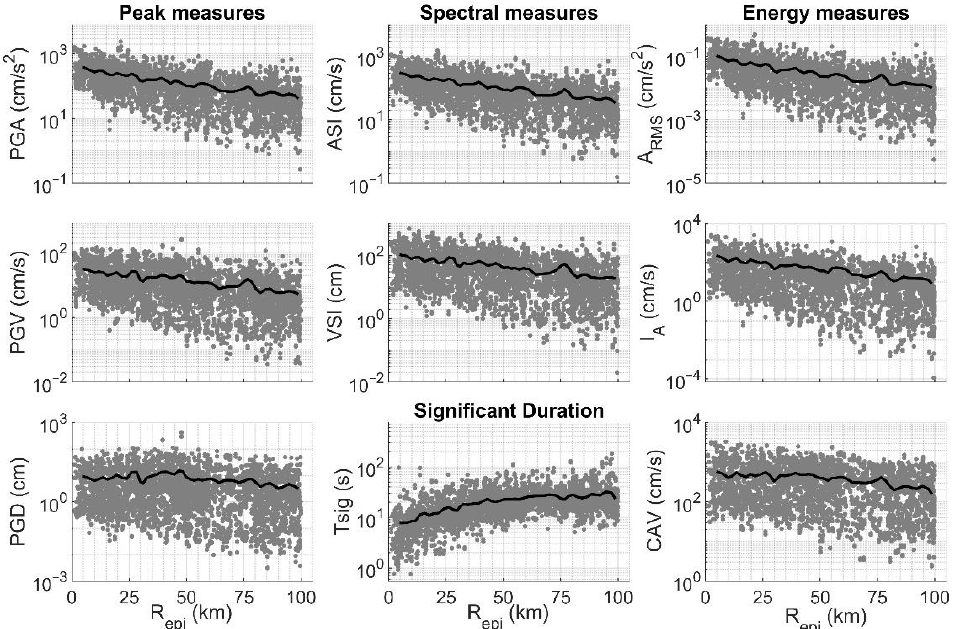
Figure 2. Variation of peak amplitude, spectral, temporal, and energy intensity measures with epicentral distance. Black solid lines represent the moving average. PGA and PGV decrease with epicentral distance, whereby the attenuation of PGA is stronger. PGD follows a constant trend with distance. Spectral intensity measures and energy measures decrease with distance, except for CAV , which remains almost invariant. Significant duration ( Tsig ) increases with distance.